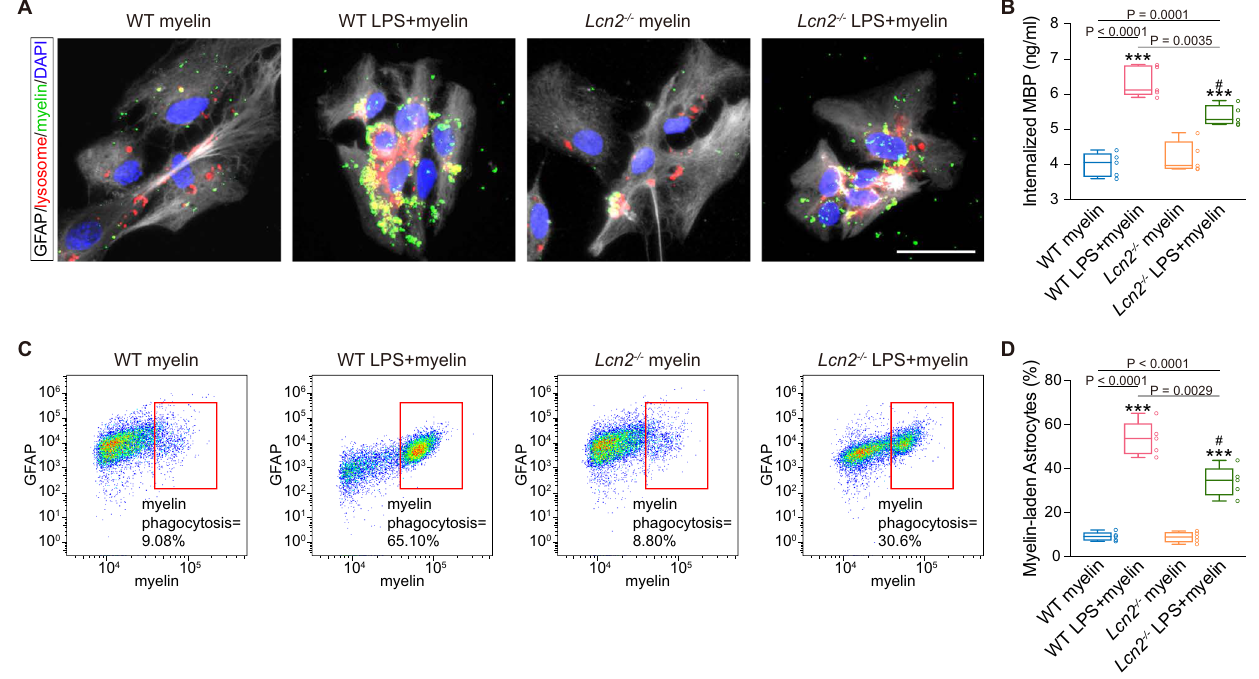
Fig. 5 Absence of Lcn2 attenuates astrocytic phagocytosis in vitro. A Representative immunostaining images of astrocytic phagocytosis, GFAP-positive (gray), lysosomes-positive (LysoTracker Red dye, red) and CFSE-labeled myelin debris (green) of WT and Lcn2 − / − primary astrocytes with or without LPS pre-treatment ( n = 5 independent primary cell cultures). Scale bar, 20 μ m. B ELISA analysis for internalized MBP in primary astrocytes of two genotypes ( n = 5 independent primary cell cultures; mean ± S.D.; adjusted *** P < 0.0002 vs. WT myelin; # P < 0.0083 vs. WT LPS + myelin; two-way ANOVA, repeated-measures t -test). C , D Flow cytometry showing the differences of astrocytes to internalize myelin debris ( n = 5 independent primary cell cultures; mean ± S.D.; adjusted *** P < 0.0002 vs. WT myelin; # P < 0.0083 vs. WT LPS + myelin; two-way ANOVA, repeated-measures t -test). In the box plots ( B , D ), the middle bar represents the median, the box represents the interquartile range, and whiskers indicate the maximum and minimum values. Dots are all the data points. Source data are provided as a Source Data fi length was detected between WT and Lcn2 − / − dMCAO mice